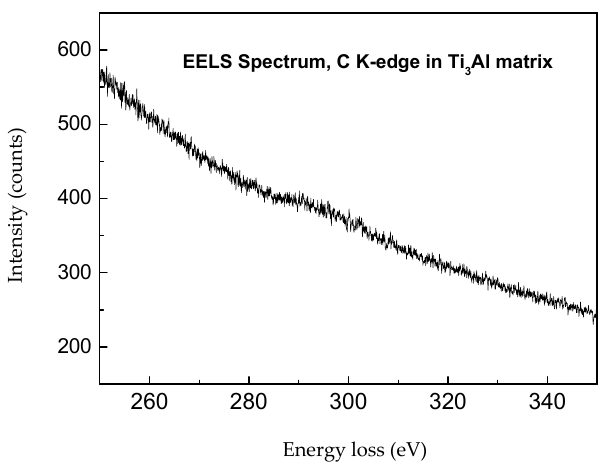
Figure 13. EELS spectrum in surface sublayer, K Edge C (284 eV).